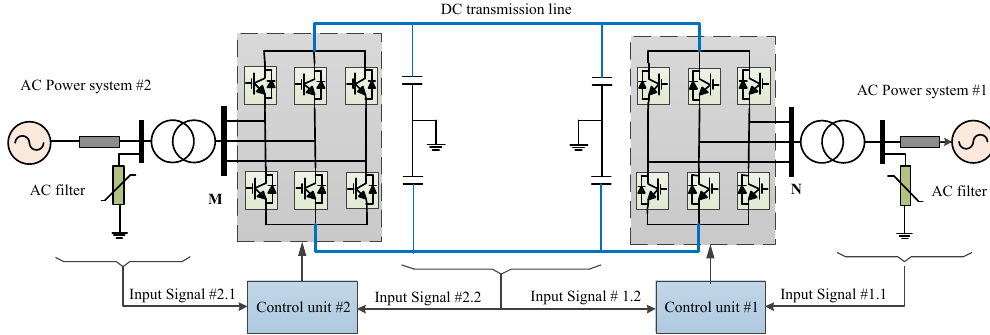
Figure 1. Structure of the voltage source converter based high voltage direct current (VSC-HVDC) system.